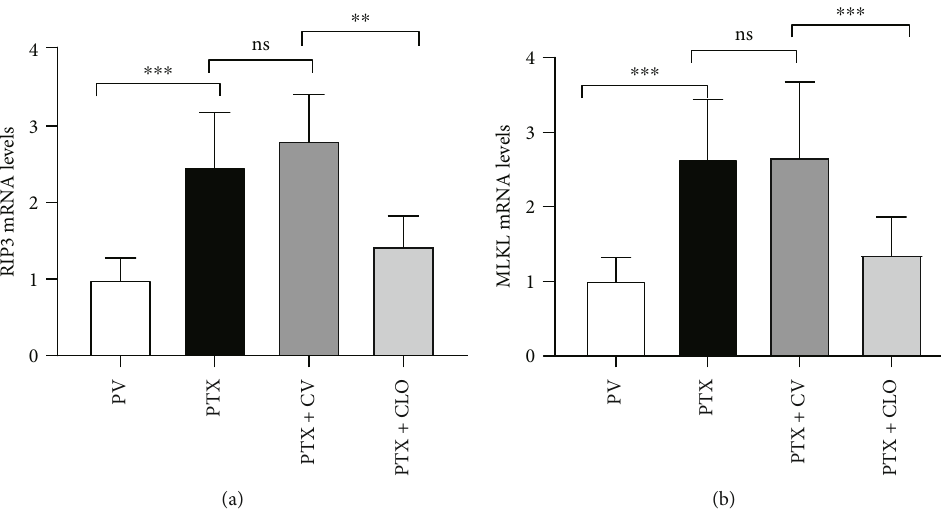
Figure 5: Expression of RIP3 and MLKL mRNA in rats with PIPN evaluated via qRT-PCR. Data are expressed as the mean ± SD ( n = 6 in each group). The results were analyzed using one-way ANOVA followed by the LSD post hoc test. Asterisks indicate signi fi cant di ff erence between two groups at ∗∗ P < 0 : 01 , ∗∗∗ P < 0 : 001 ; ns: no signi fi cant di ff erence between two groups. Abbreviations: RIP3, receptor-interacting protein kinase 3; MLKL, mixed-lineage kinase domain-like protein; PTX, paclitaxel; CLO, clodronate disodium liposomes.